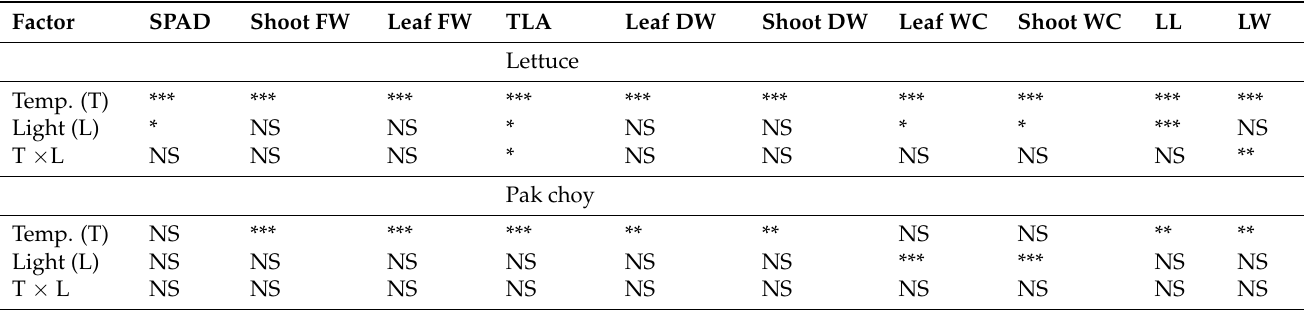
Table 1. Summary of analysis of variance (ANOVA) on the effects of temperature (T) and light spectrum (L) on leaf SPAD index, plant growth, and morphology: shoot fresh weight (FW), leaf FW,